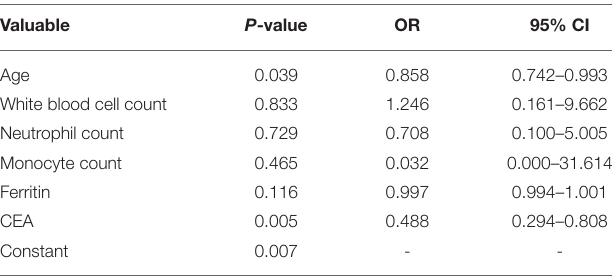
TABLE 4 | Binary logistic regression analysis of factors related to COVID-19 severities. Valuable